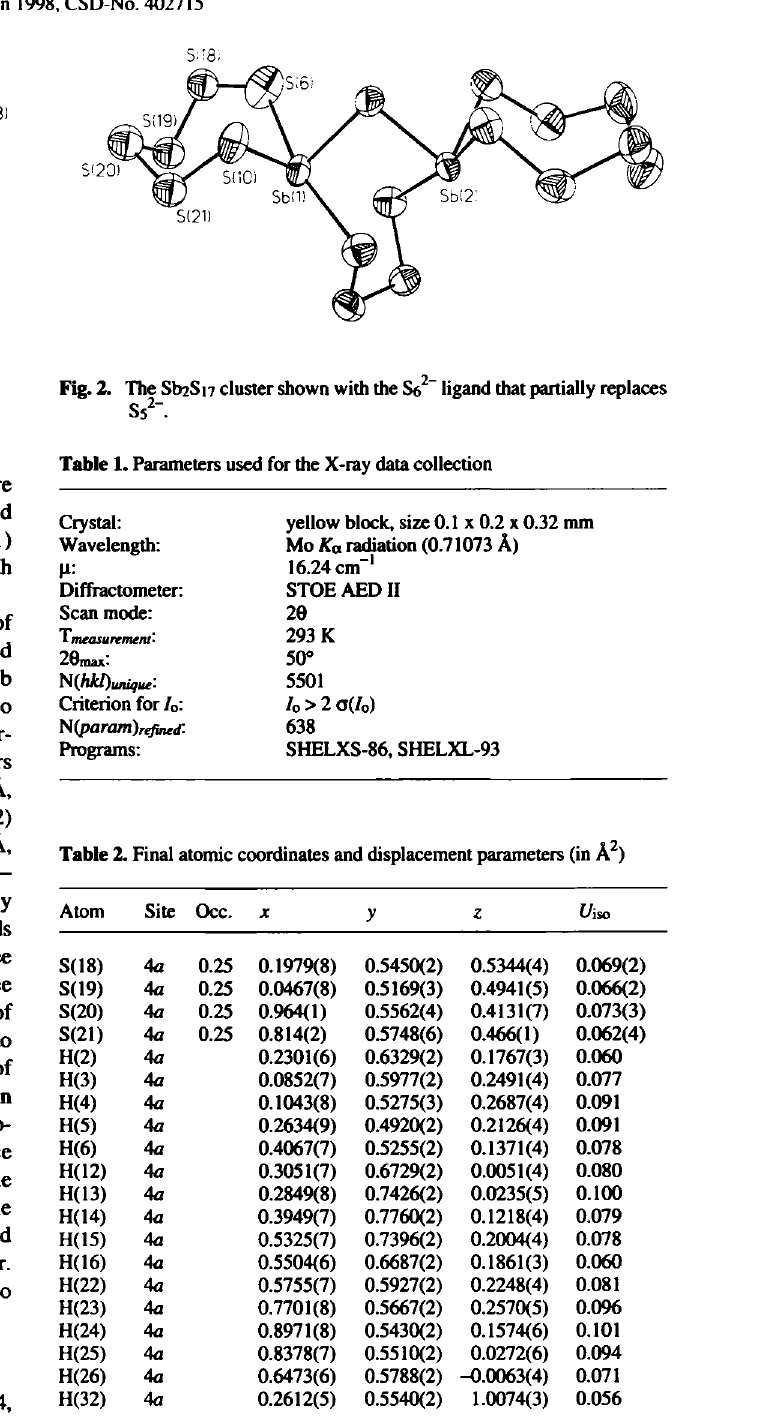
Fig. 1. The SbîSn cluster. Fig. 2. The Sb2S,7 cluster shown with the Se 2 ligand that partially replaces